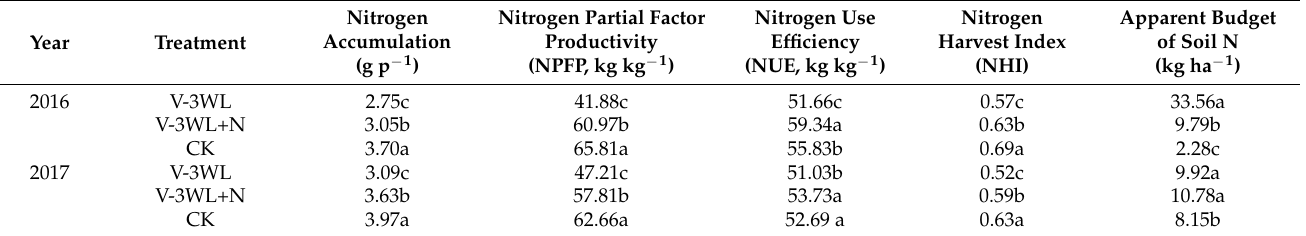
Table 2. Effects of applying nitrapyrin on the nitrogen accumulation and nitrogen efficiency under 253 a waterlogged field.